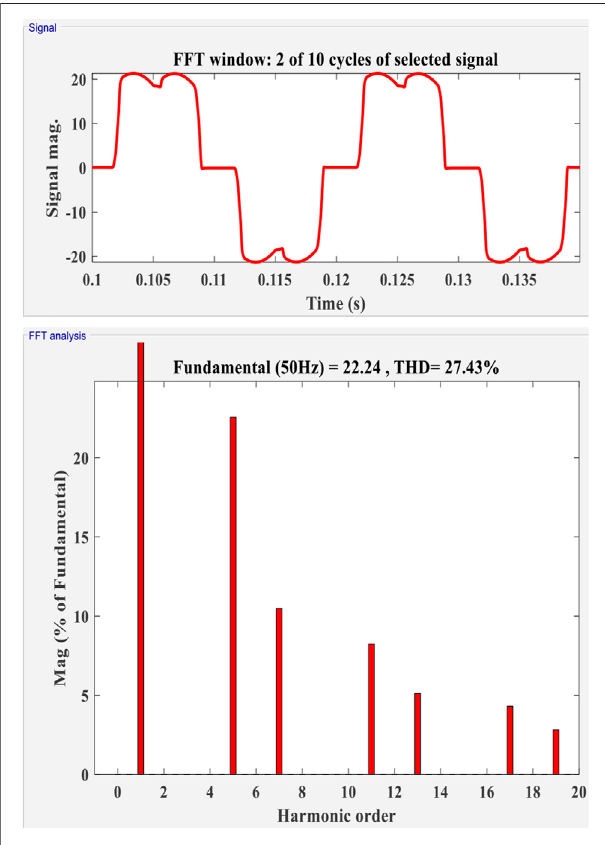
FIGURE 11 | Without the fi lter for unbalanced load source voltage (V s ), source current (I s ), and load current (I L ).